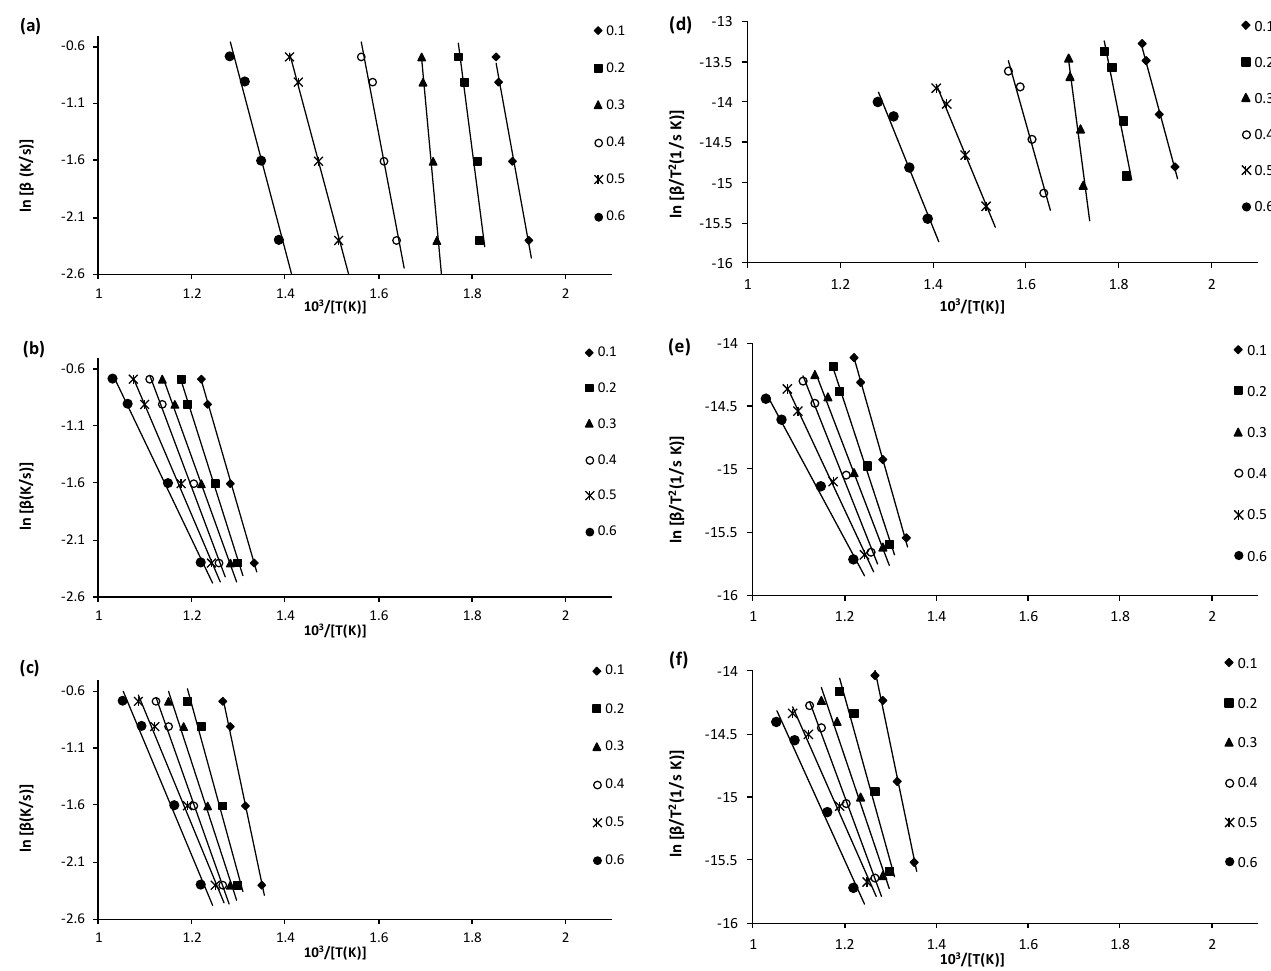
Figure 5. Results on the combustion of MB (( a ) and ( d )), BC (( b ) and ( e )) and MB-BC (( c ) and ( f )) at the different heating rates together with fittings to the iso-conversional kinetic models of FWO (( a ), ( b ), and ( c )) and KAS (( e ), ( d ), and ( f )). Note: The Y -axis of graphs was adjusted for the correct visualization of results.